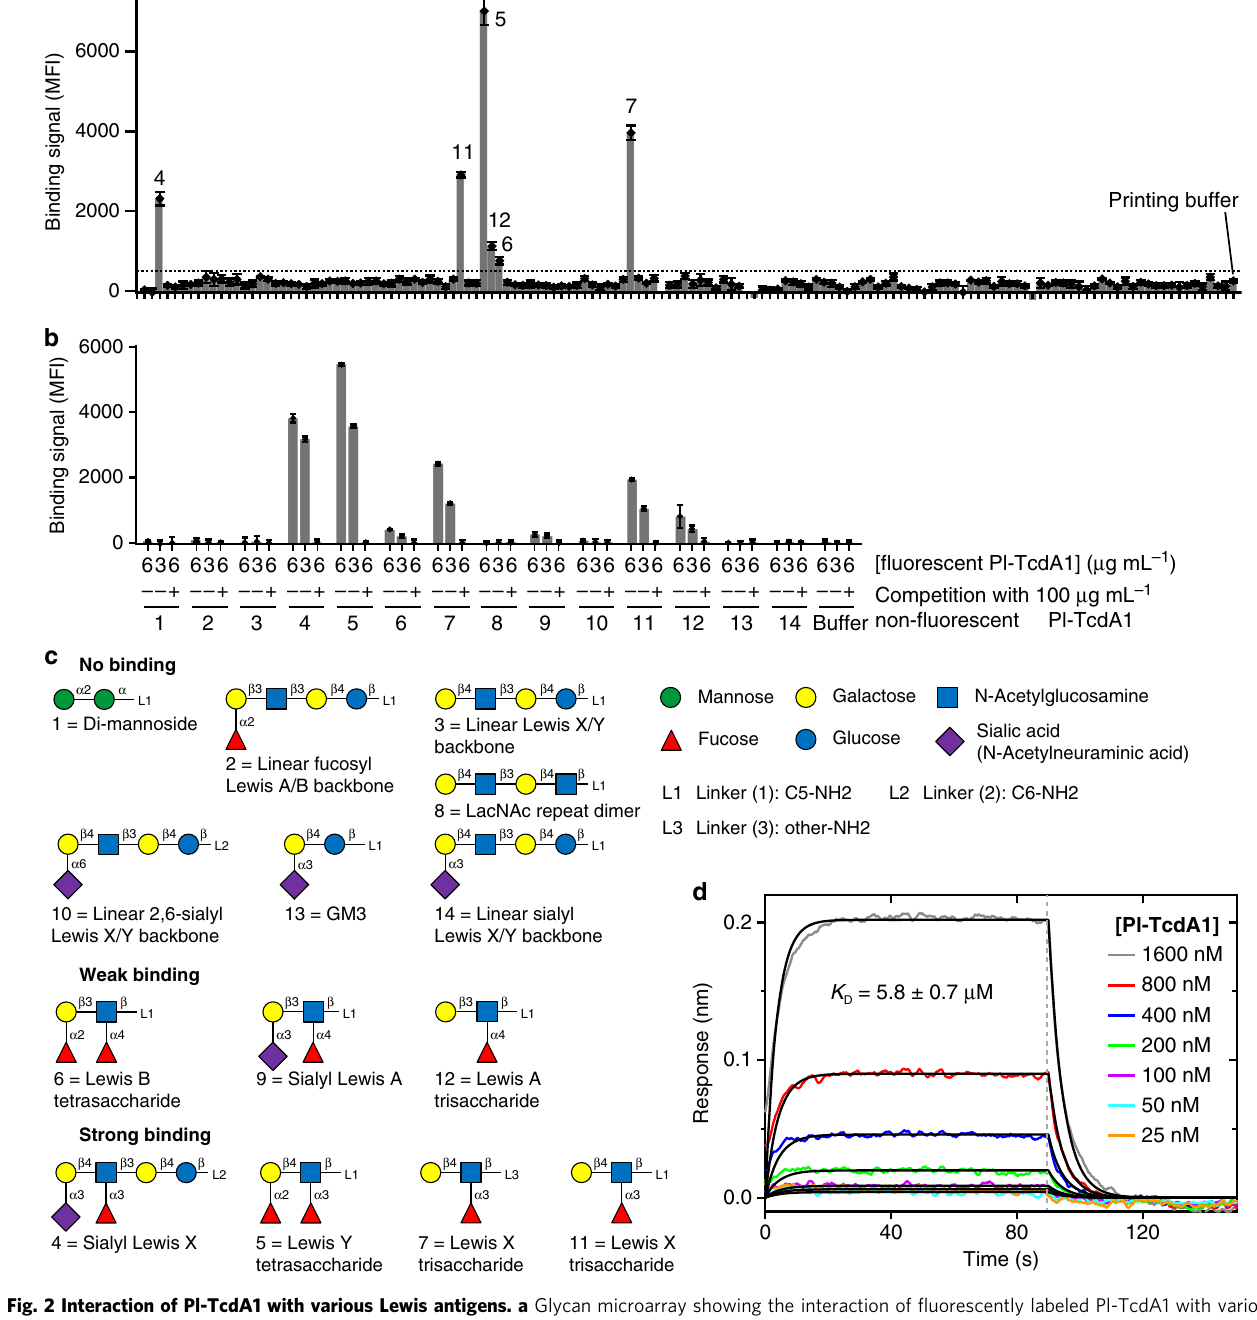
Fig. 2 Interaction of Pl-TcdA1 with various Lewis antigens. a Glycan microarray showing the interaction of fl uorescently labeled Pl-TcdA1 with various glycans. Binding signals are shown as local background-subtracted mean fl uorescence intensity (MFI) values to 141 synthetic glycans. MFI values are indicated as bars. An arbitrary threshold of MFI = 500 is indicated as dashed line. b Focused microarray with selected glycans from ( a ). 6 or 3 μ g/mL of fl uorescent Pl-TcdA1 were applied to 14 different glycans (indicated below the bar diagrams, spotted at 0.1 mM) in the absence or presence of an excess of unlabeled Pl-TcdA1. The error bars in panels ( a ) and ( b ) represent standard deviations of four measurements. c Schematic representation of glycans used on the focused microarray, grouped by binding of Pl-TcdA1 (no binding, weak binding, and strong binding). The individual monosaccharide moieties are shown on the top right (green circle: mannose, yellow circle: galactose, blue square: N -acetylglucosamine, red triangle: fucose, blue circle: glucose, violet diamond: sialic acid). For subsequent cryo-EM and BLI experiments, Lewis X (compound 7) was conjugated to BSA (Supplementary Fig. 2b). d BLI sensorgrams of Pl-TcdA1 interacting with immobilized BSA-Lewis X. TcA pentamer concentrations were 25 – 1600 nM. A global fi t according to a 1:1 binding model was applied (black curves), resulting in a dissociation constant ( K D ) of 5.8 ± 0.7 μ M, k on of 3.8 ± 0.4 × 10 4 M − 1 s − 1 , and k off of 2.2 ± 0.04 × 10 − 1 s − 1 . Association and dissociation phases are separated by a gray dashed line. The source data underlying panels ( a ) and ( b ) are provided as a Source Data fi